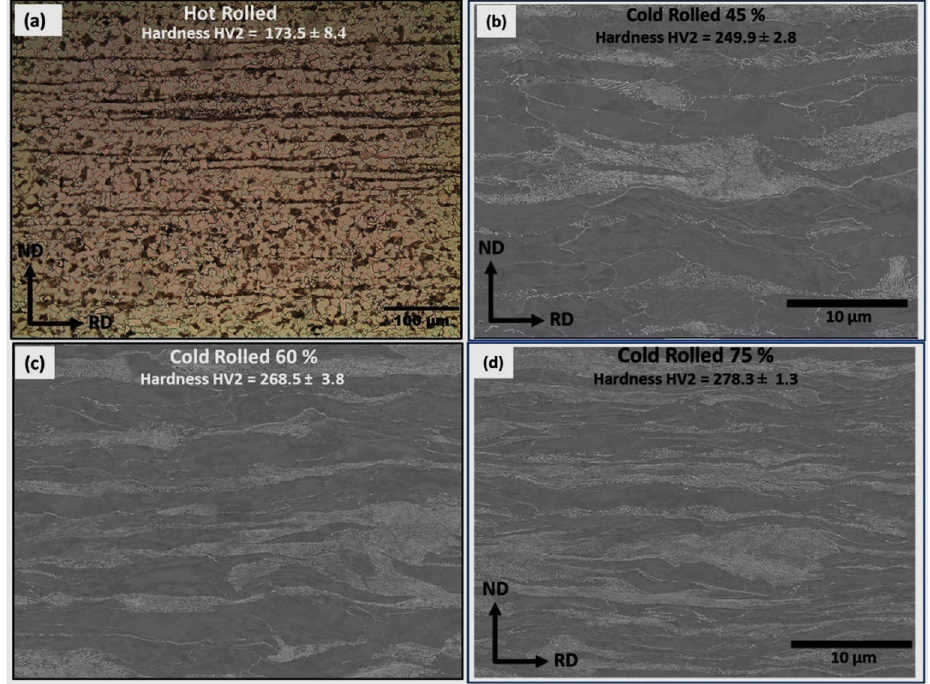
Figure 3. ( a ) Optical micrograph of hot rolled Variant 1 steel. ( b – d ) SEM micrograph of cold rolled 45%, 60% and 75% Variant 1 samples.